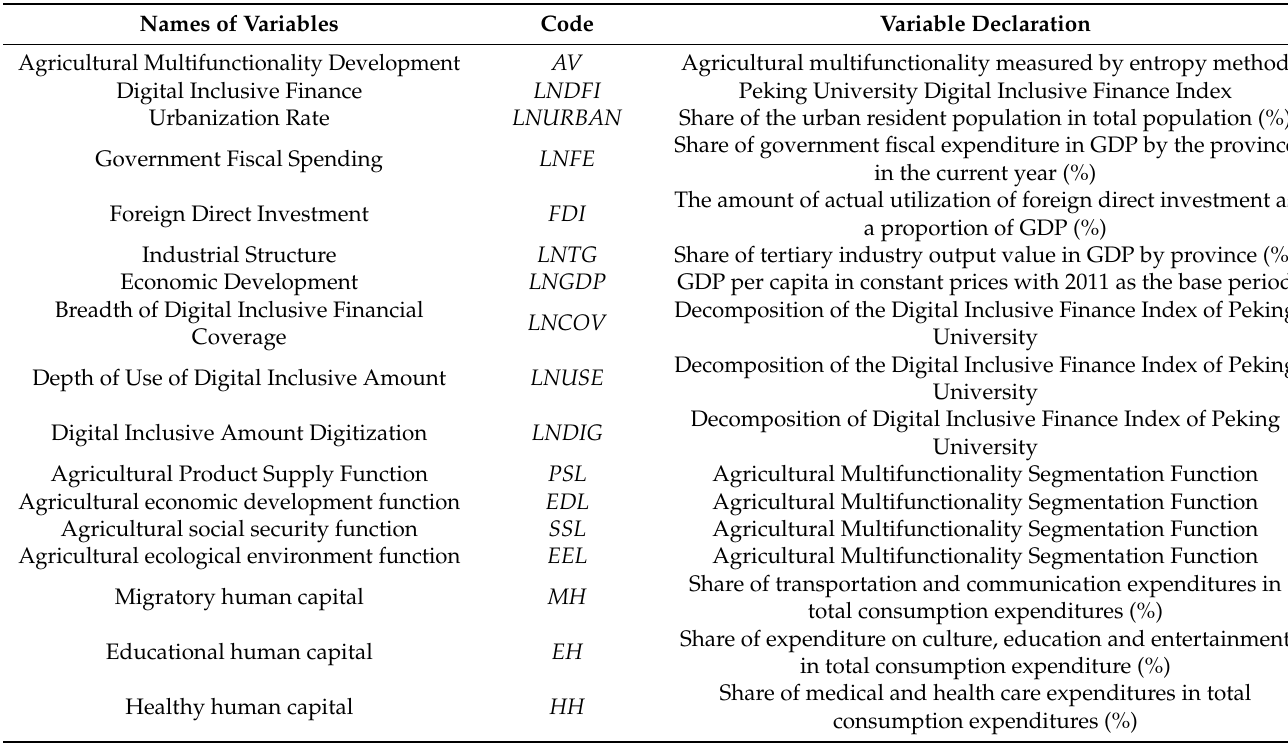
Table 2. Variable description.